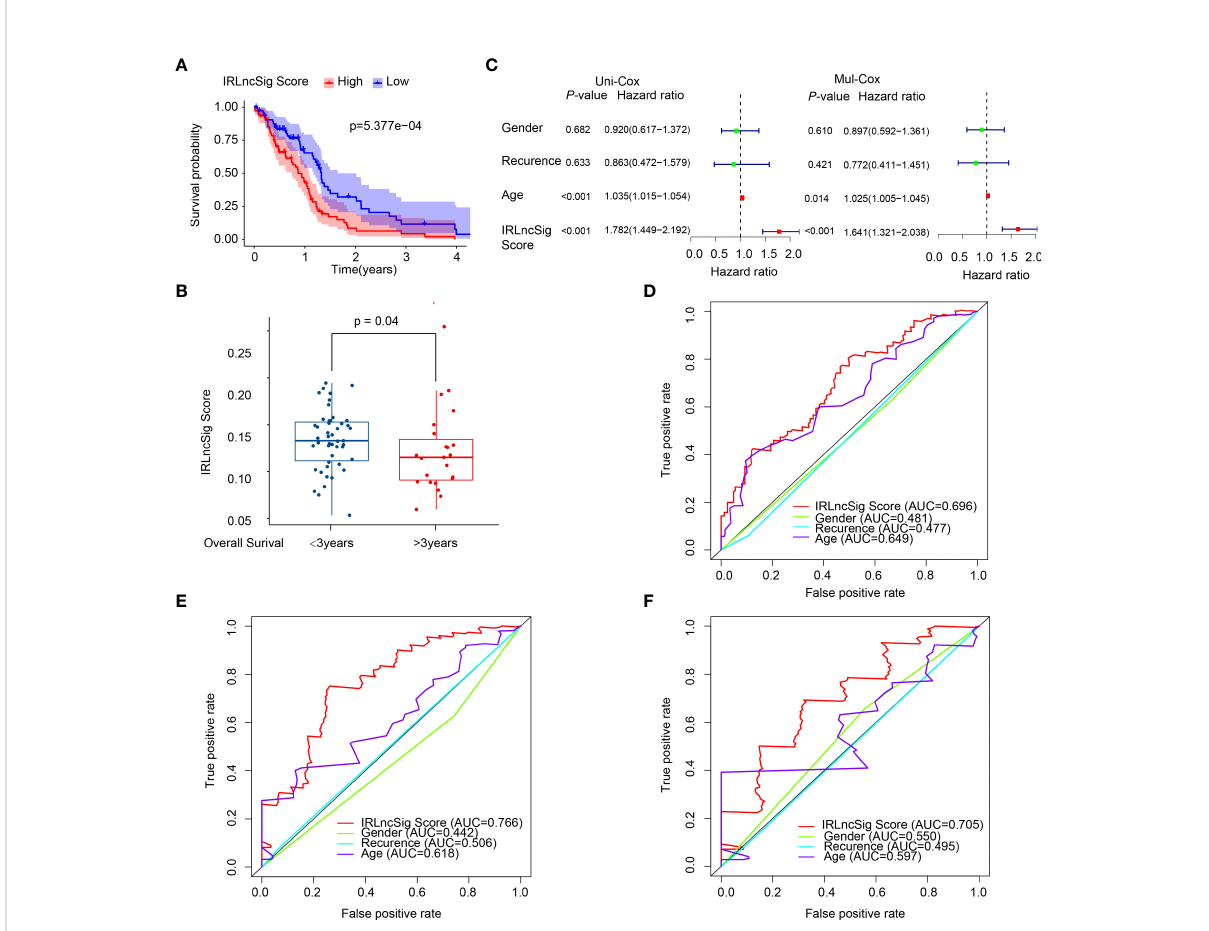
FIGURE 2 Construction and evaluation of the prognostic model. (A) The prognostic analysis of patients in the low-IRLncSig-score and high-IRLncSig- score groups by the Kaplan – Meier test of TCGA patients. (B) The Wilcoxon test of IRLncSig scores between the long-term survival group (overall survival >36 months) and short-term survival group (overall survival ≤ 36 months) of GEO patients. (C) The univariate and multivariate Cox regression prognostic analysis. (D) Time-dependent ROC curve analysis of IRLncSig and the other three features at 1 year. (E) Time- dependent ROC curve analysis of IRLncSig and the other three features at 2 years. (F) Time-dependent ROC curve analysis of IRLncSig and the other three features at 3 years. IRLncSig, immune-related lncRNA signature; TCGA, The Cancer Genome Atlas; GEO, Gene Expression Omnibus database; time-dependent ROC, time-dependent receiver operating